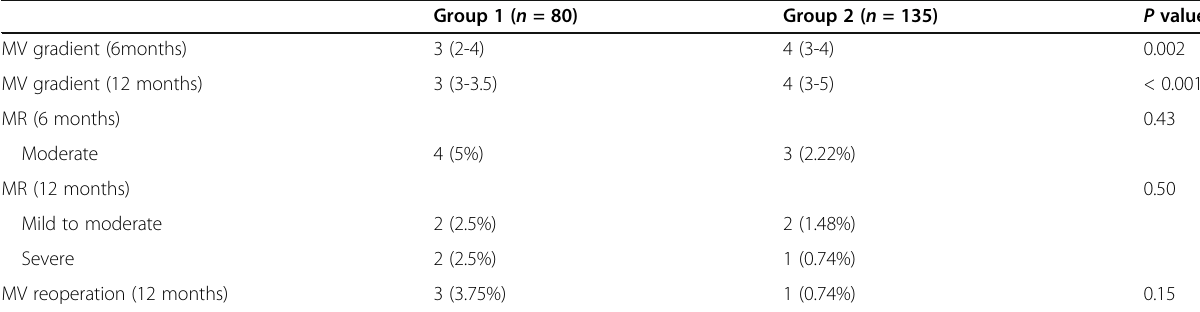
Table 5 Follow-up data